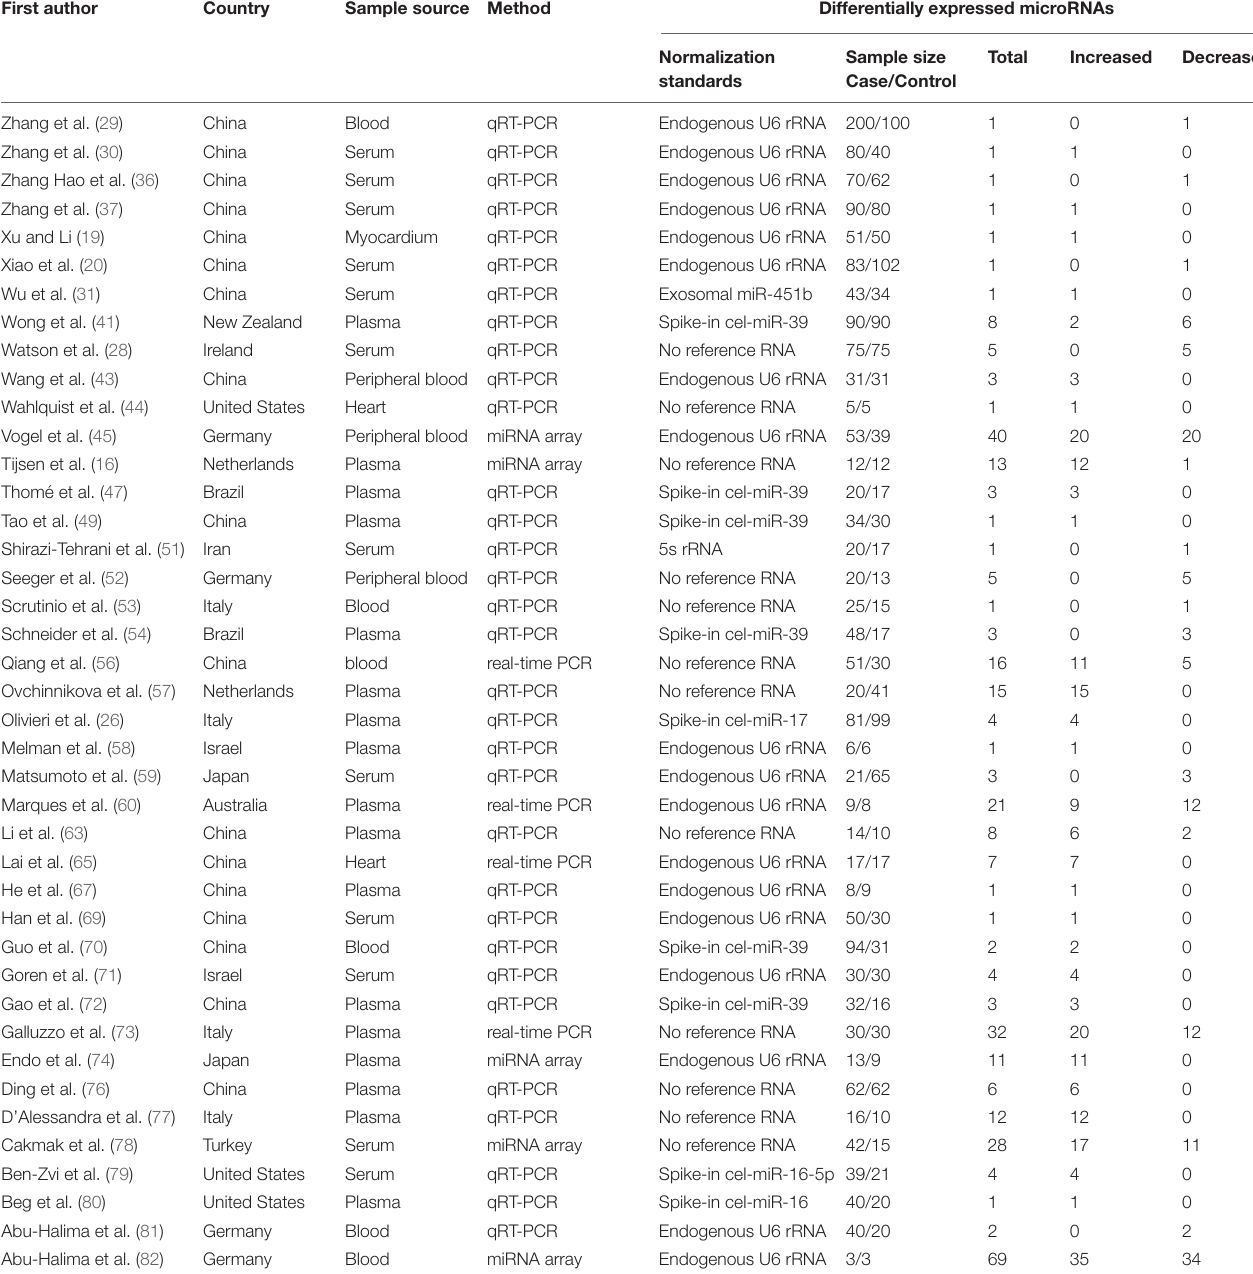
TABLE 1 | The characteristics of the included human miRNA expression